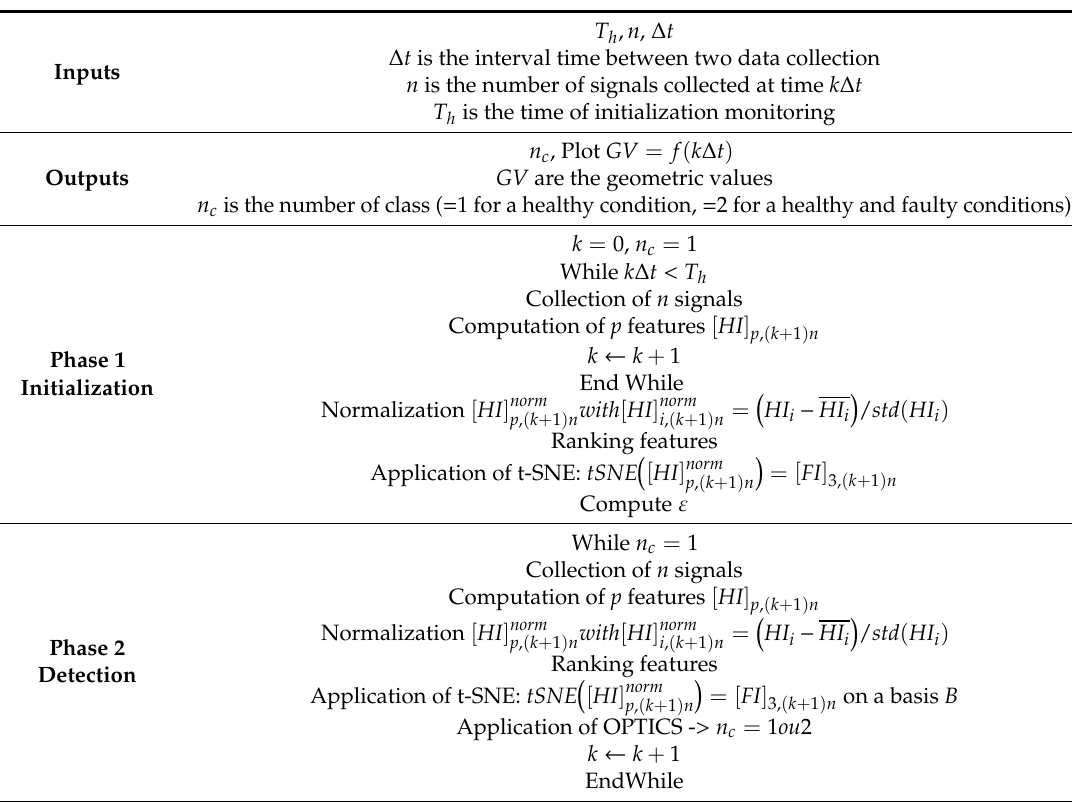
Figure 2. Flowchart of AOC-OPTICS. Table 1. Pseudocode for automatic online classification monitoring based on ordering points to identify clustering structure